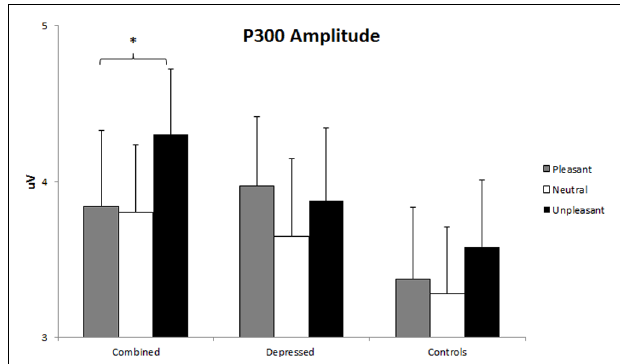
FIGURE 5 | P300 amplitude over right hemisphere. Error bars represent 1 SE. P300 amplitude valence effect (unpleasant > pleasant) over right hemisphere sensors (P1, P3, CP1, CP3) in the combined group.The asterisk represents p < 0.05 in the combined group (unpleasant > pleasant).